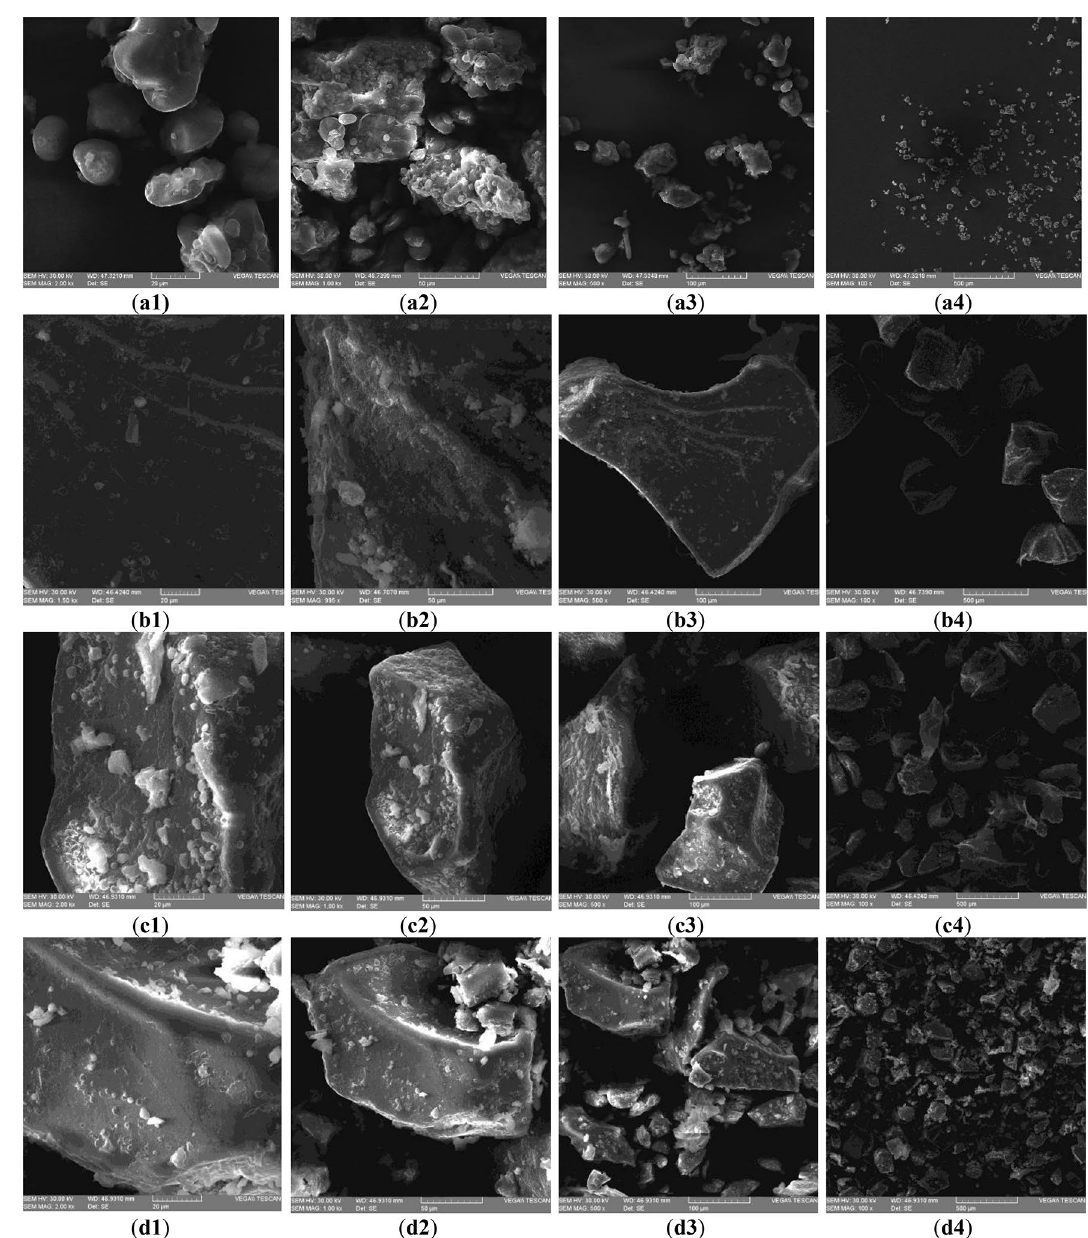
Figure 1. Microstructure of wheat flour ( a1 – a4 ) and amaranth flour large particle size ( b1 – b4 ), medium particle size ( c1 – c4 ), and small particle size ( d1 – d4 ) at different magnifications: ×2000 (1), ×1000 (2), ×500 (3) and ×100